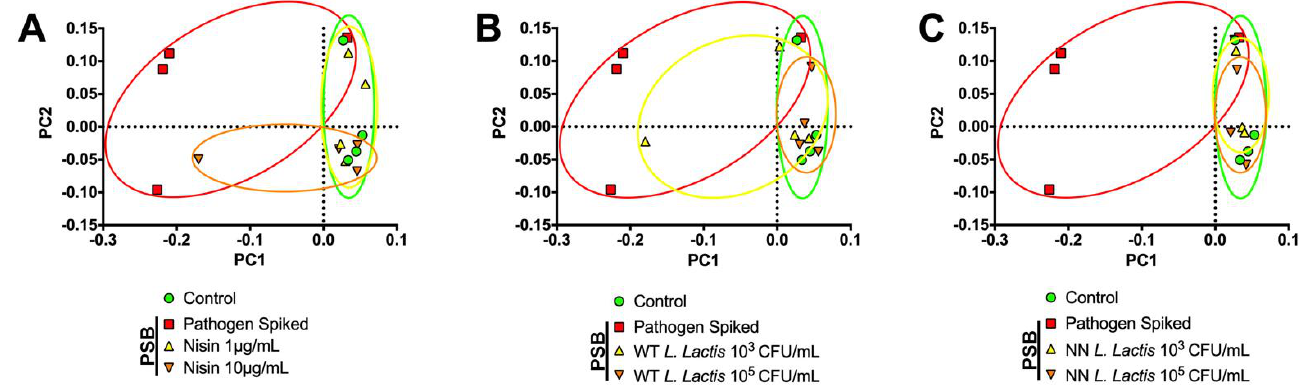
Figure 8. Nisin and the probiotic effectively bring PCoA variables/distance of the pathogen-spiked oral biofilms back toward control levels. Images show the Principal Coordinate Analysis (PCoA) of the unweighted UniFrac distances for control biofilms and pathogen-spiked biofilms (PSB) treated with ( A ) Nisin 1 and 10 µg/mL, ( B ) WT L. lactis 10 3 and 10 5 CFU/mL and ( C ) NN L. lactis 10 3 and 10 5 CFU/mL. Colored ellipses highlight sample group distance.